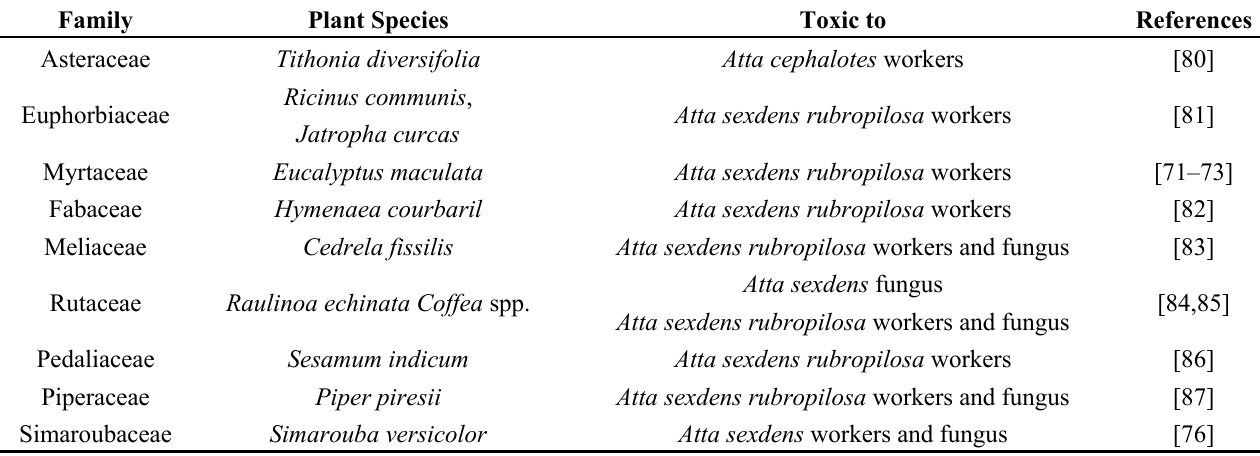
Table 2. Plants that can be toxic to leaf-cutting ants and/or to their fungus and their references